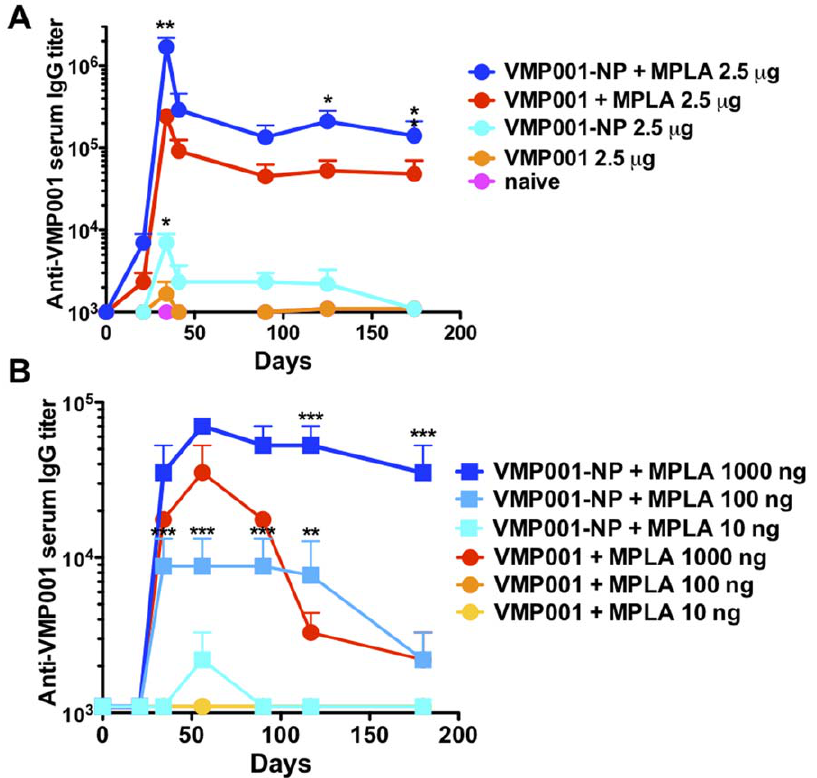
Figure 2. VMP001-NP vaccination mediates potent humoral immune responses. (A) C57Bl/6 mice were immunized s.c. on days 0 and 21 with 2.5 m g of VMP001 in either soluble or VMP001-NP formulations, with or without the addition of 25 m g MPLA. Anti-VMP001 IgG serum titer were monitored over time by ELISA. (B) C57Bl/6 mice were immunized s.c. on days 0 and 21 with the indicated doses of VMP001 in either soluble or VMP001-NP formulations with the fixed dose of 25 m g MPLA admixed in all groups. *, p , 0.05, **, p , 0.01, and ***, p , 0.001, for VMP001-NP formulations compared to soluble VMP001 vaccines at the same dose of antigen, analyzed by two-way ANOVA followed by Bonferroni post-tests.